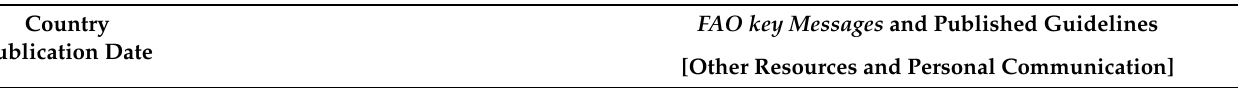
Table 1. Country Specific Guidelines for Dietary